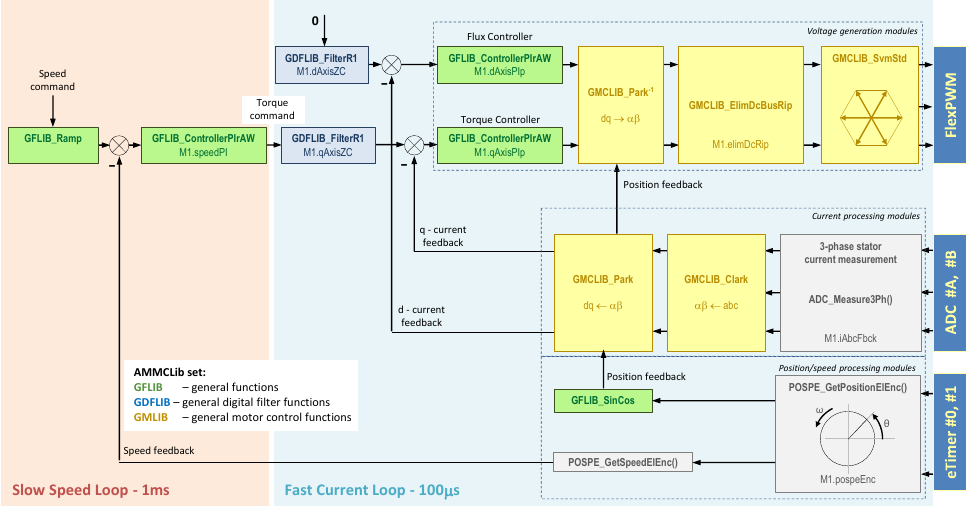
Figure 8. Variables and functions as implemented in FOC calculation for MPC5643L